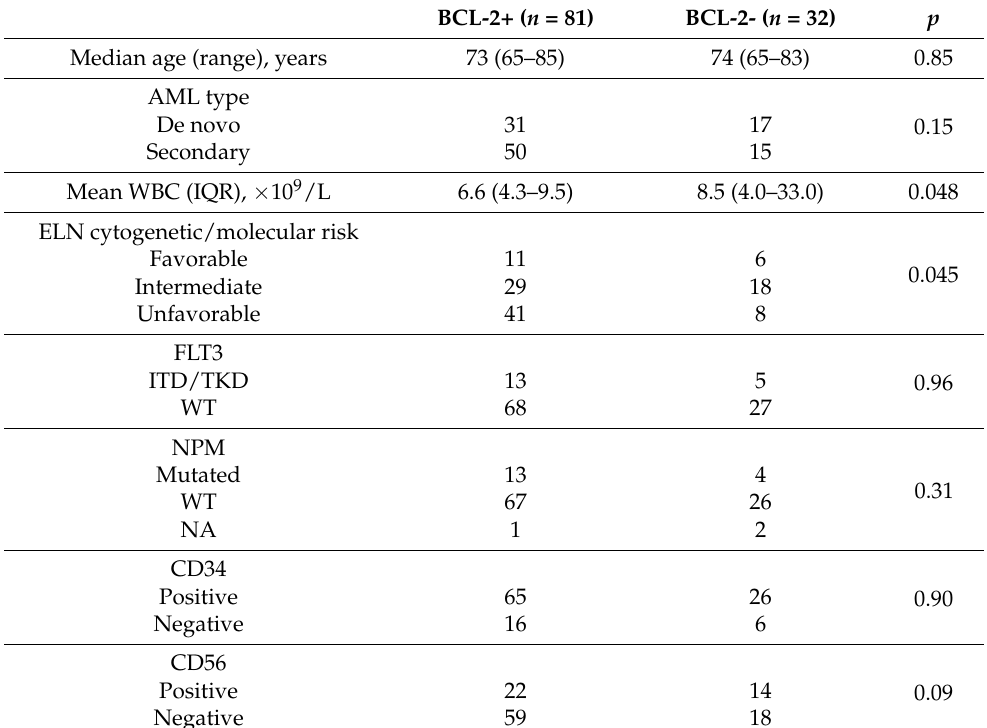
Table 1. Patients’ characteristics according to BCL-2